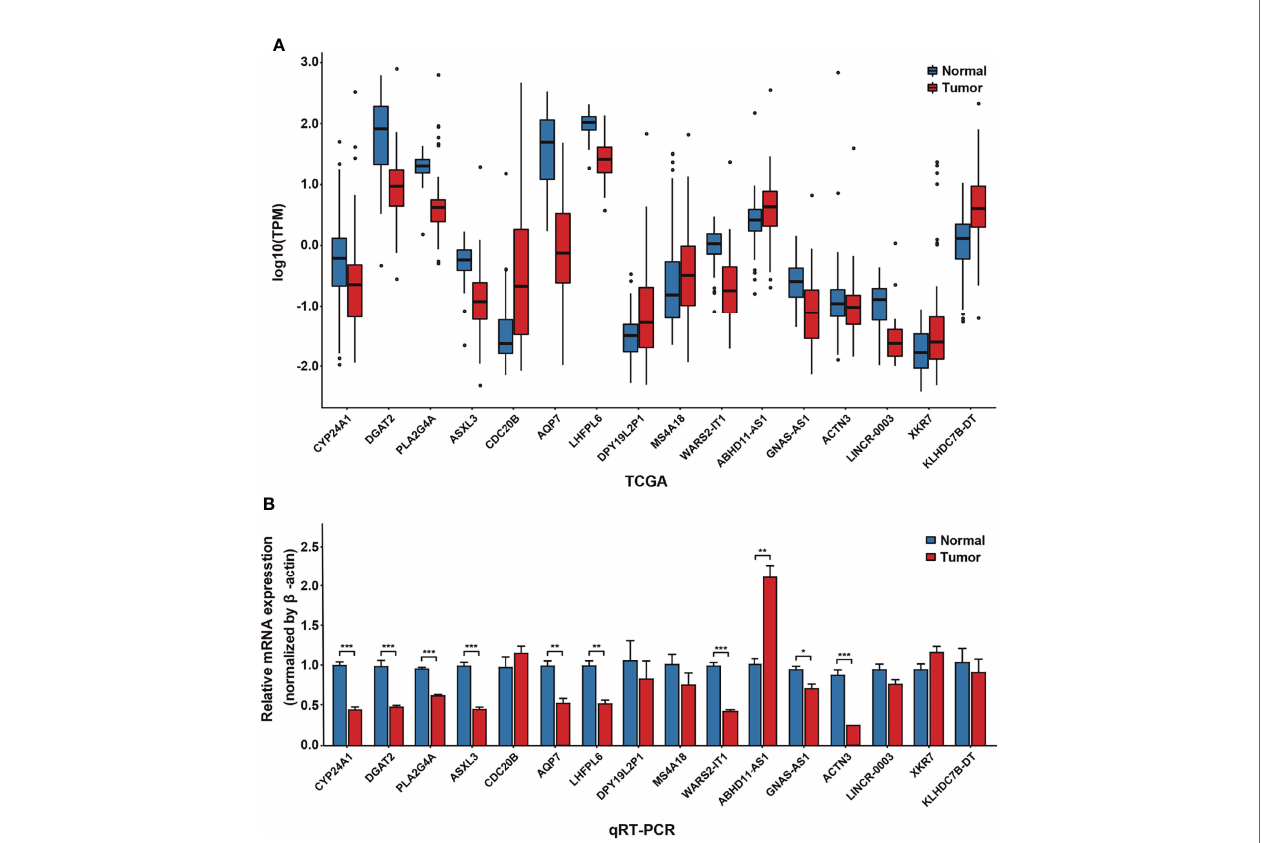
FIGURE 4 | Veri fi cation of differential expression of hub genes by quantitative real-time polymerase chain reaction (qRT-PCR). (A) Expression of 16 hub genes in 96 cancer samples and 96 adjacent cancer samples, obtained from the Cancer Genome Atlas. (B) Expression of 16 hub genes in the MCF-7 cell line and normal breast cells by qRT-PCR. * P < 0.05; ** P < 0.01; *** P <